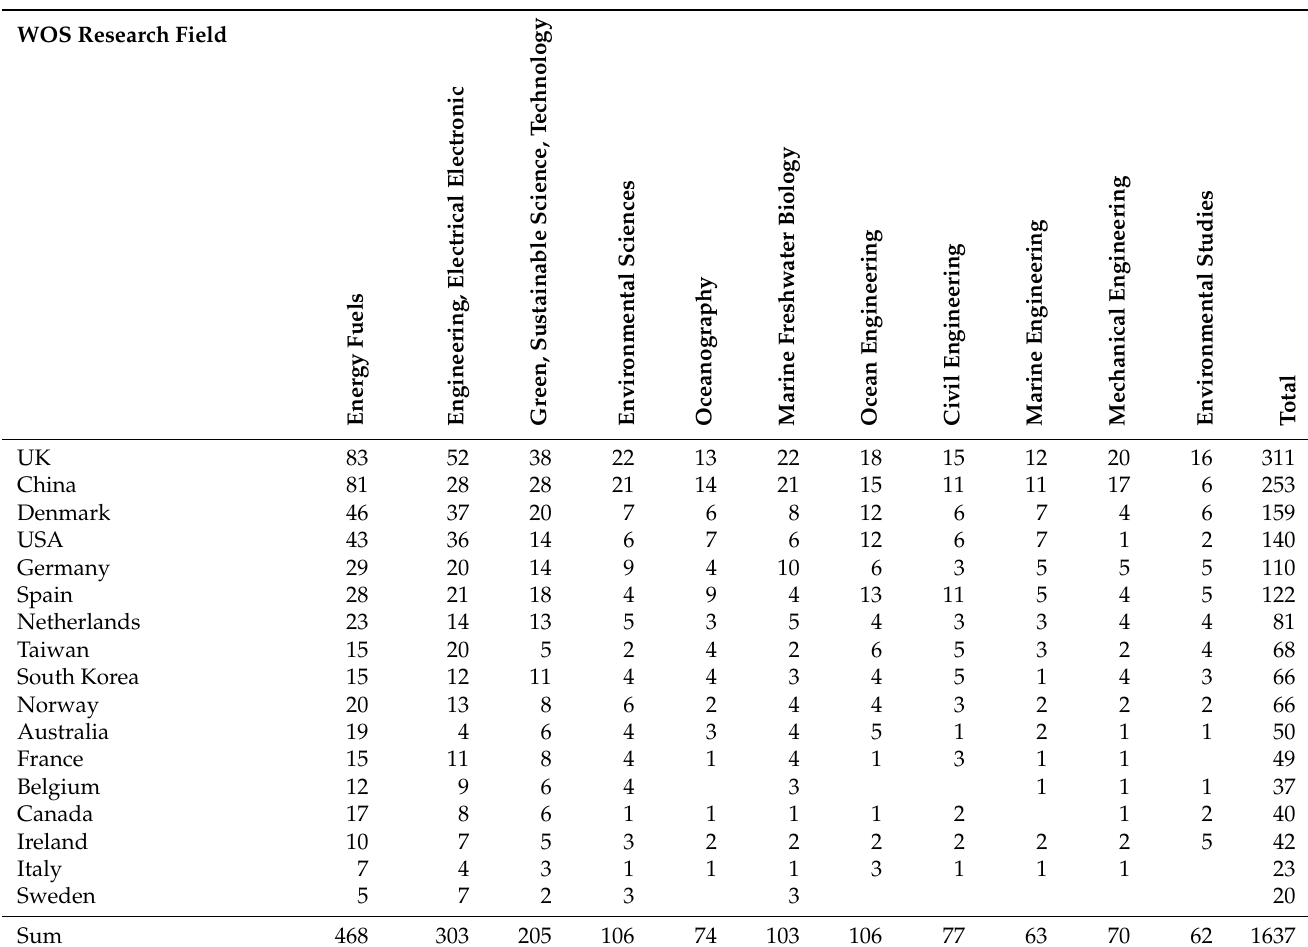
Table 3. The research fields of the WOS papers related to offshore wind farms by the major contribut- ing